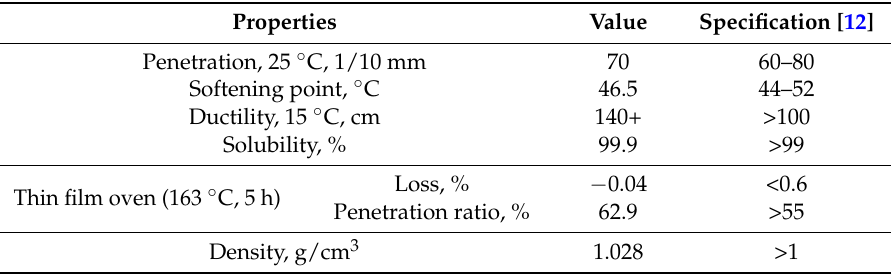
Table 4. Properties of asphalt.